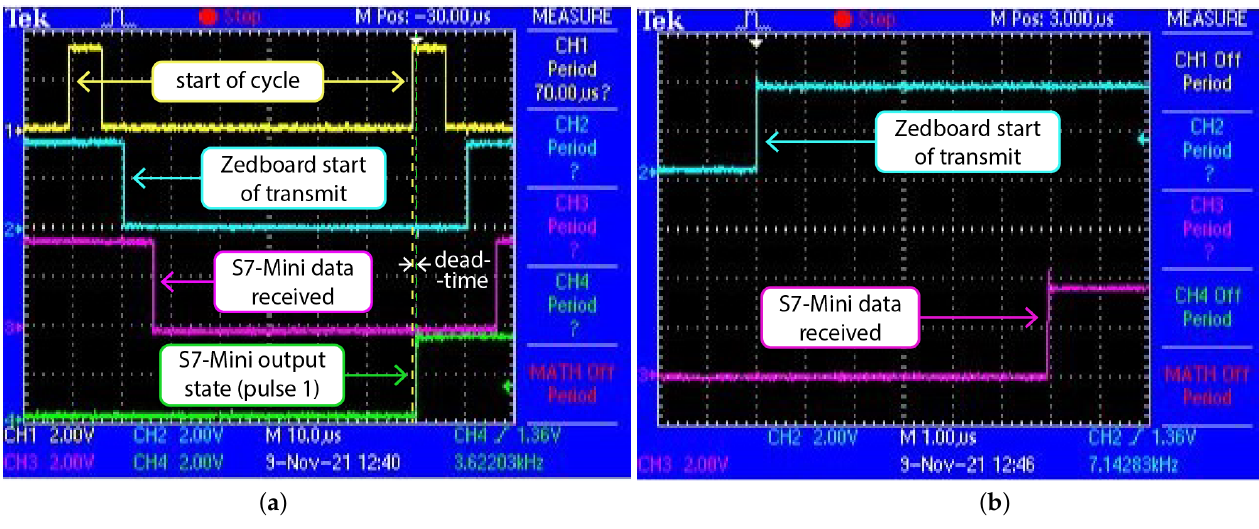
Figure 24. ZedBoad output expansion using a secondary S7-Mini FPGA. ( a ) Sampling, communica- tion, and update times. ( b ) Zedboard to S7-Mini communication